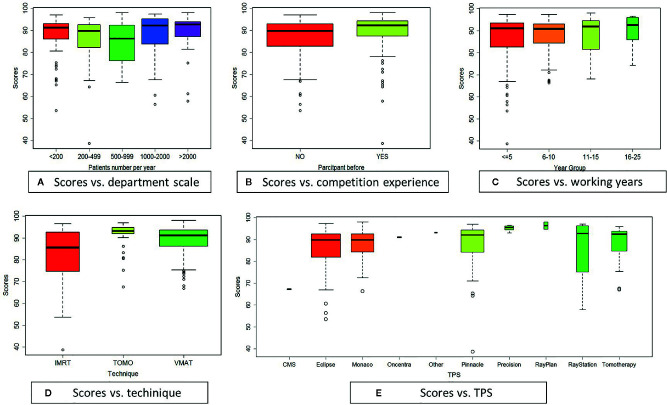
Boxplots graphically presenting correlations with plan score: (A) department scale, (B) competition experiment, (C) working year, (D) technique, (E) TPS.